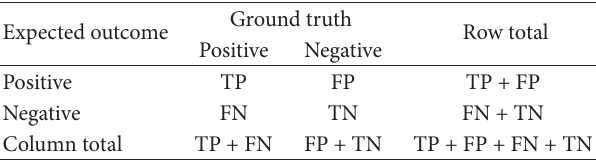
Table 3: Confusion matrix defining the terms TP, TN, FP, and FN.